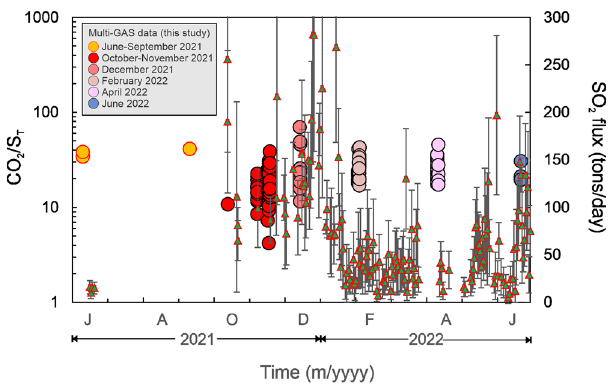
Fig. 9 Evolution of the unrest through early 2022. Temporal record of bulk plume SO 2 fl uxes from La Fossa (red-bordered green triangles, data from Supplementary Table 1; error bars correspond to 1 standard deviation of the daily averaged fl ux) and fumarole molar CO 2 /S T ratios (circles) in the period June 2021 to June 2022. A drop of SO 2 fl ux emissions is visible since January 2022, followed by some moderate increase in May to June 2022. The CO 2 /S T ratios in 2022 are higher than in October – November 2021, but still below background (see June to September 2021 data for